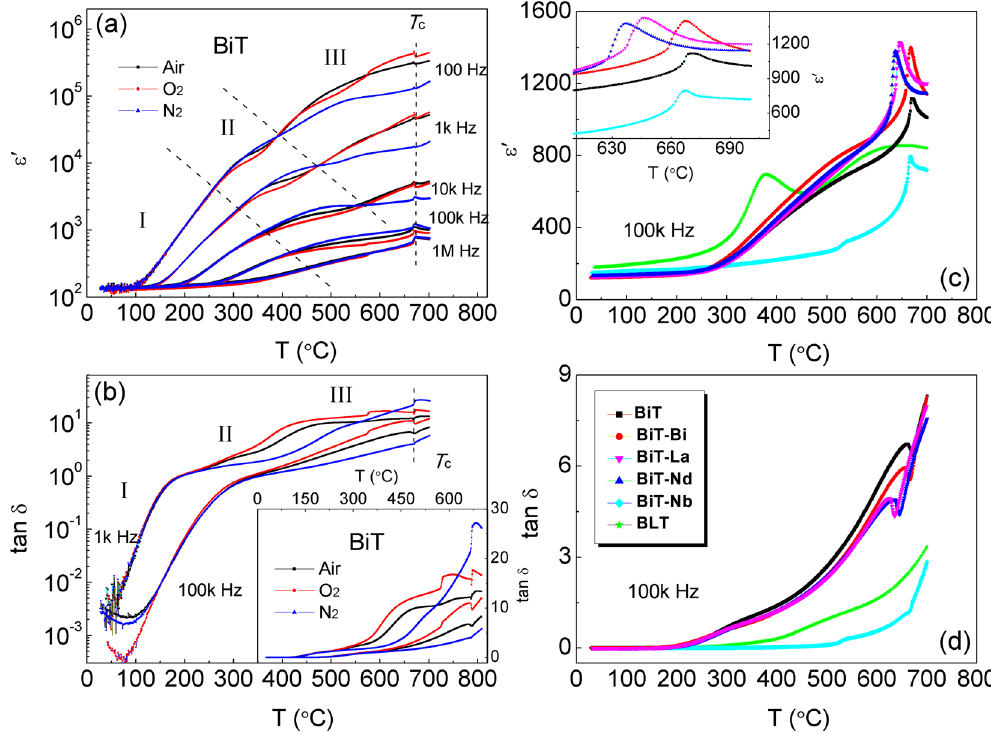
Figure 10. ( a ) Log ε ′ vs. T and ( b ) log tan δ vs. T plots for the air-, O 2 - and N 2 -processed BiT samples, and tan δ vs. T plots for the air-, O 2 - and N 2 -processed BiT as an inset in ( b ). ( c ) ε ′ vs. T and ( d ) tan δ vs. T plots for the air- processed BiT, BiT-A, BLT and BiT-Nb samples, with an inset showing regionally enlarged drawing for ε ′ vs. T plots in ( c